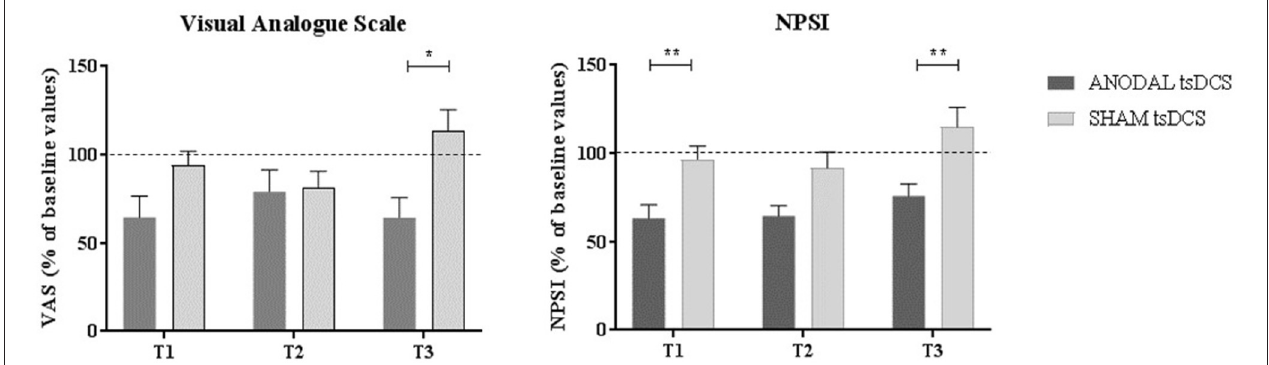
FIGURE 3 | Clinical assessment of pain changes. Left: VAS score changes over time. Right: NPSI score changes over time. Data are given as normalized to T0 mean ± SE. The statistical significance refers to the comparison between anodal (active) and sham (placebo) stimulation (* p < 0.05; ** p < 0.001, Wilcoxon’s test post-hoc